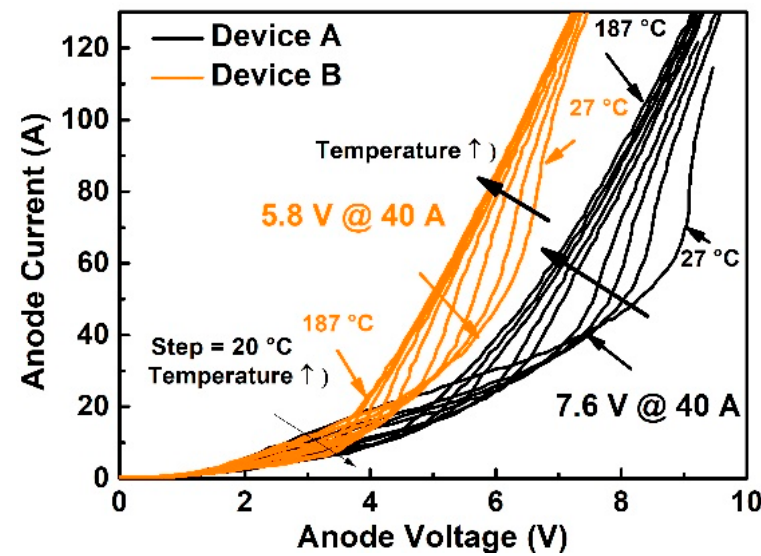
Figure 6. JBS forward characteristic at elevated temperature.